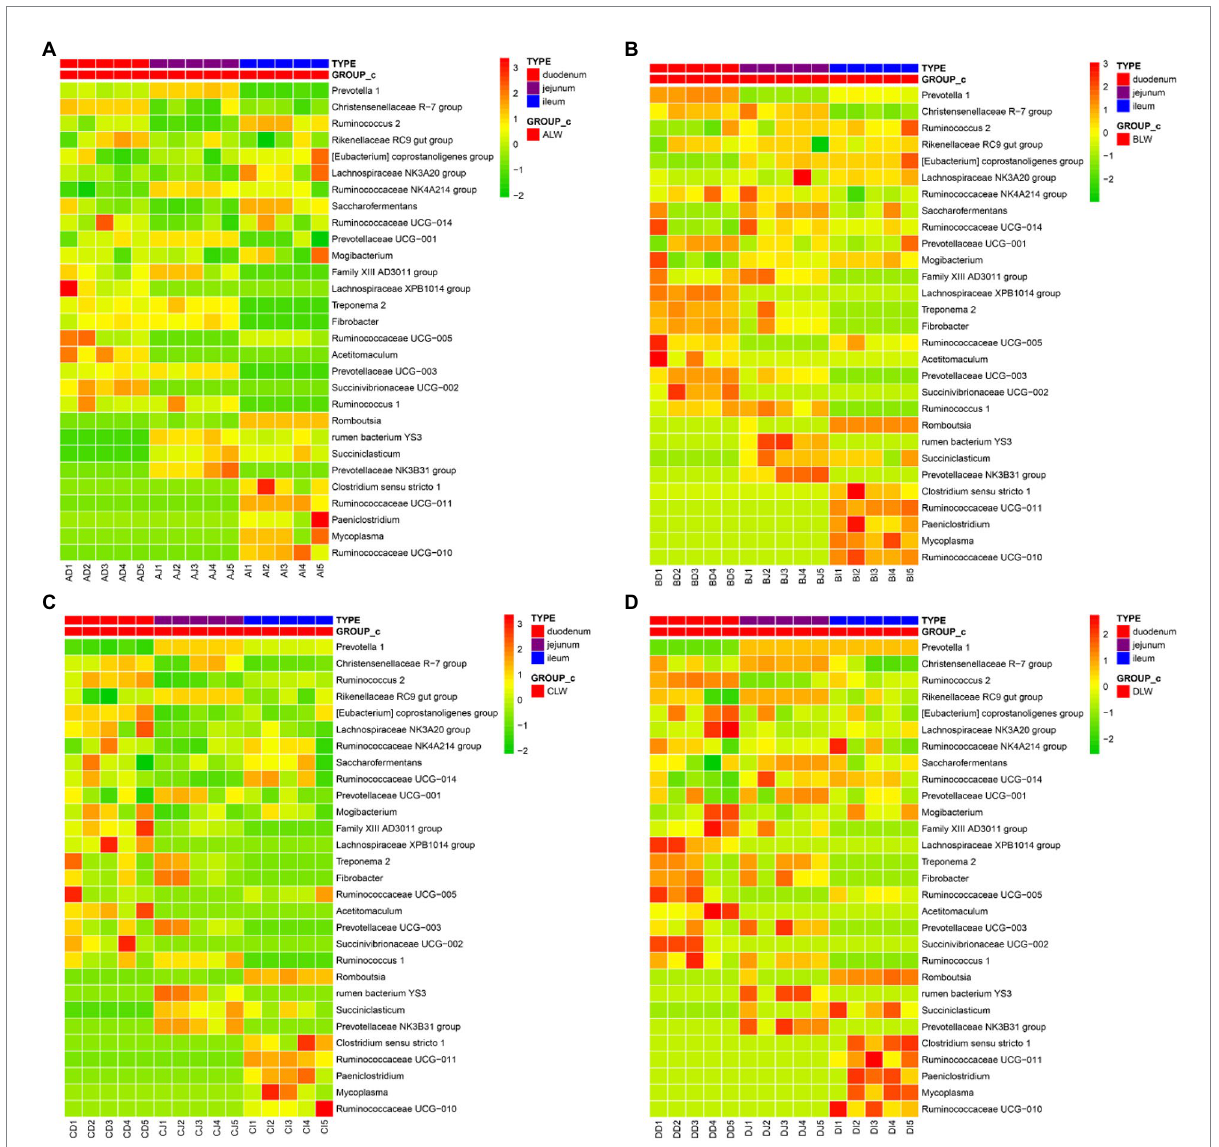
FIGURE 7 (A) Heat map of microbial distribution at the genus level in the ALW group (B) Heat map of microbial distribution at the genus level in the BLW group (C) Heat map of microbial distribution at the genus level in the CLW group (D) Heat map of microbial distribution at the genus level in the DLW